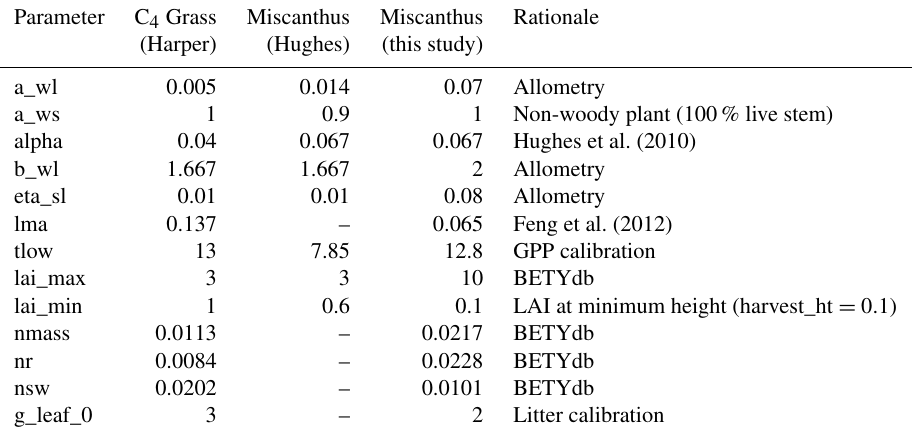
Table 3. PFT parameters distinguishing the Miscanthus PFT used in this study. “C 4 Grass” parameters are taken from Harper et al. (2018b); “ Miscanthus (Hughes)” are given by Hughes et al. (2010). A full list of parameters, with definitions and explanations for values used, is given in the Supplement. “–” indicates parameters that were not yet introduced in the older version of JULES used by Hughes et al. (2010). Parameters described as “Allometry” were determined via an iterative process to improve the relationships between above-ground biomass, leaf area index (LAI) and height, as described in the Supplement. Parameters described as “BETYdb” were taken from observations in the Biofuel Ecophysiological Traits and Yields database (LeBauer et al., 2018). “GPP calibration” indicates tlow was determined via an iterative process to improve the fit of modelled gross primary productivity (GPP) to the flux data obtained from the Lincolnshire site. “Litter calibration” indicates g_leaf_0 was determined via an iterative process to approximate the observed ratio of leaf litter to yield (Amougou et al., 2012). Details of these calculations are provided in the